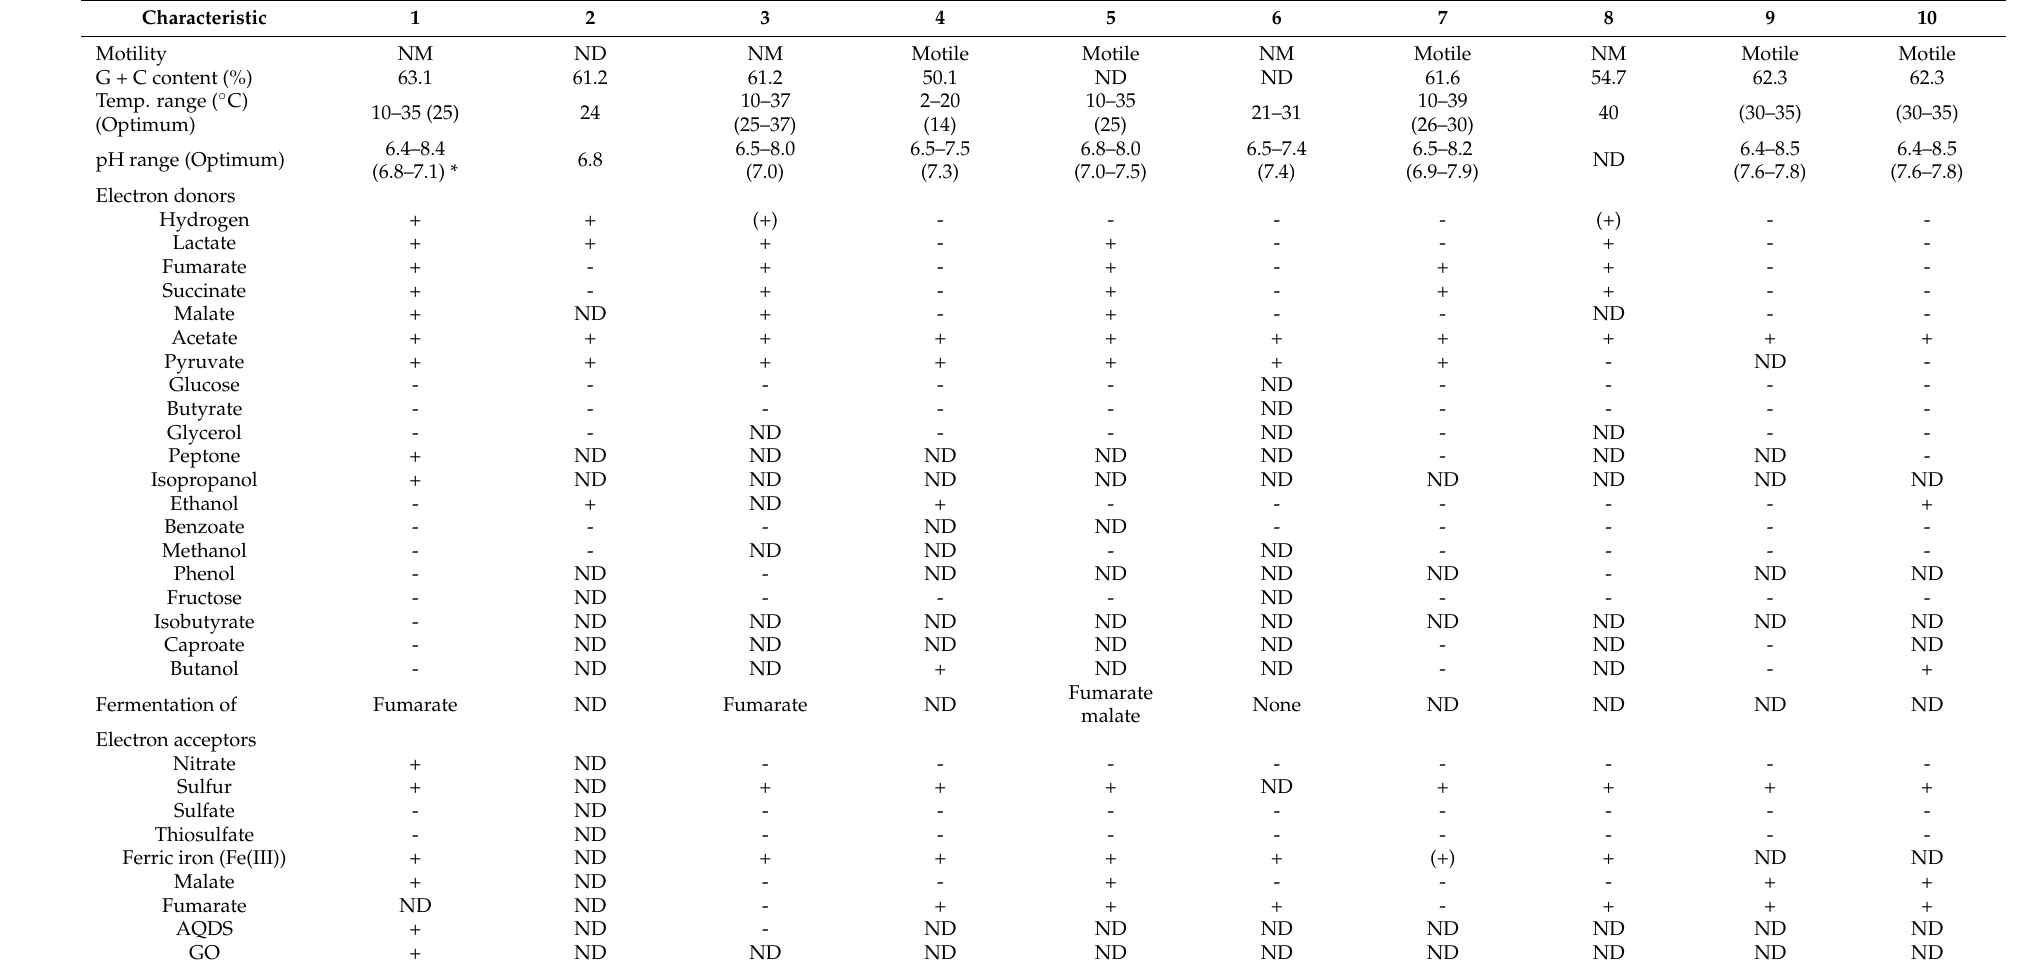
Table 1. Characteristics of strain NIT-T3 and other Desulfuromonas